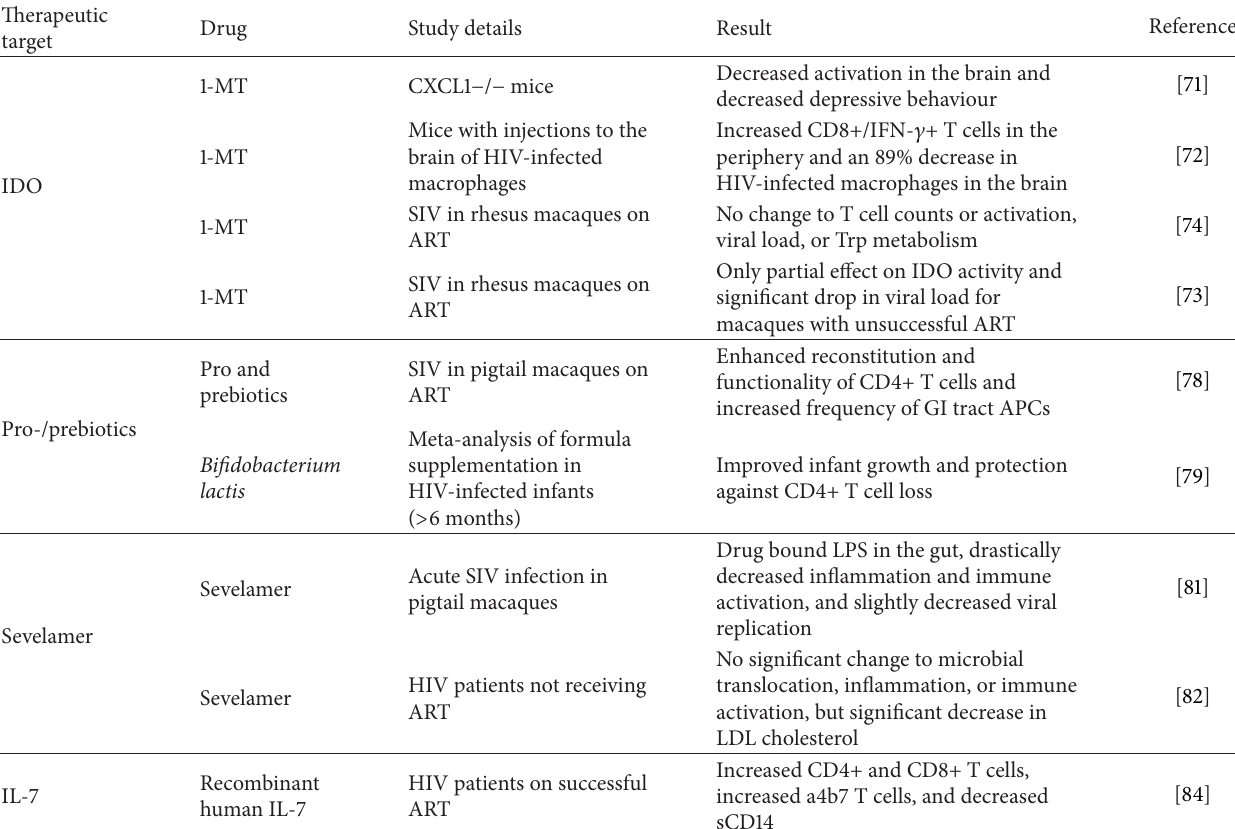
Table 1: Selected studies targeting the gut microbiota or subsequent downstream